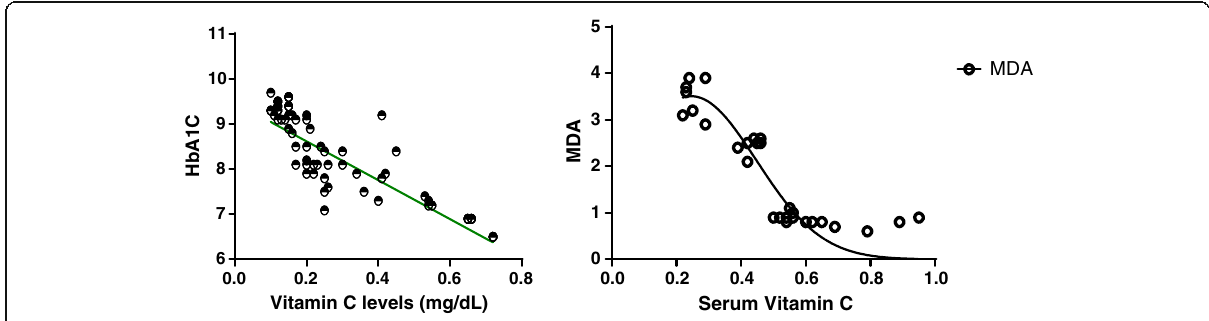
Fig. 1 Correlation between HbA1c, malondialdehyde, and serum vitamin C